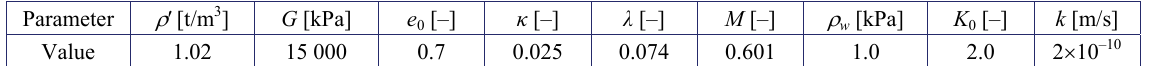
Table 2. UL model parameters with MCC model